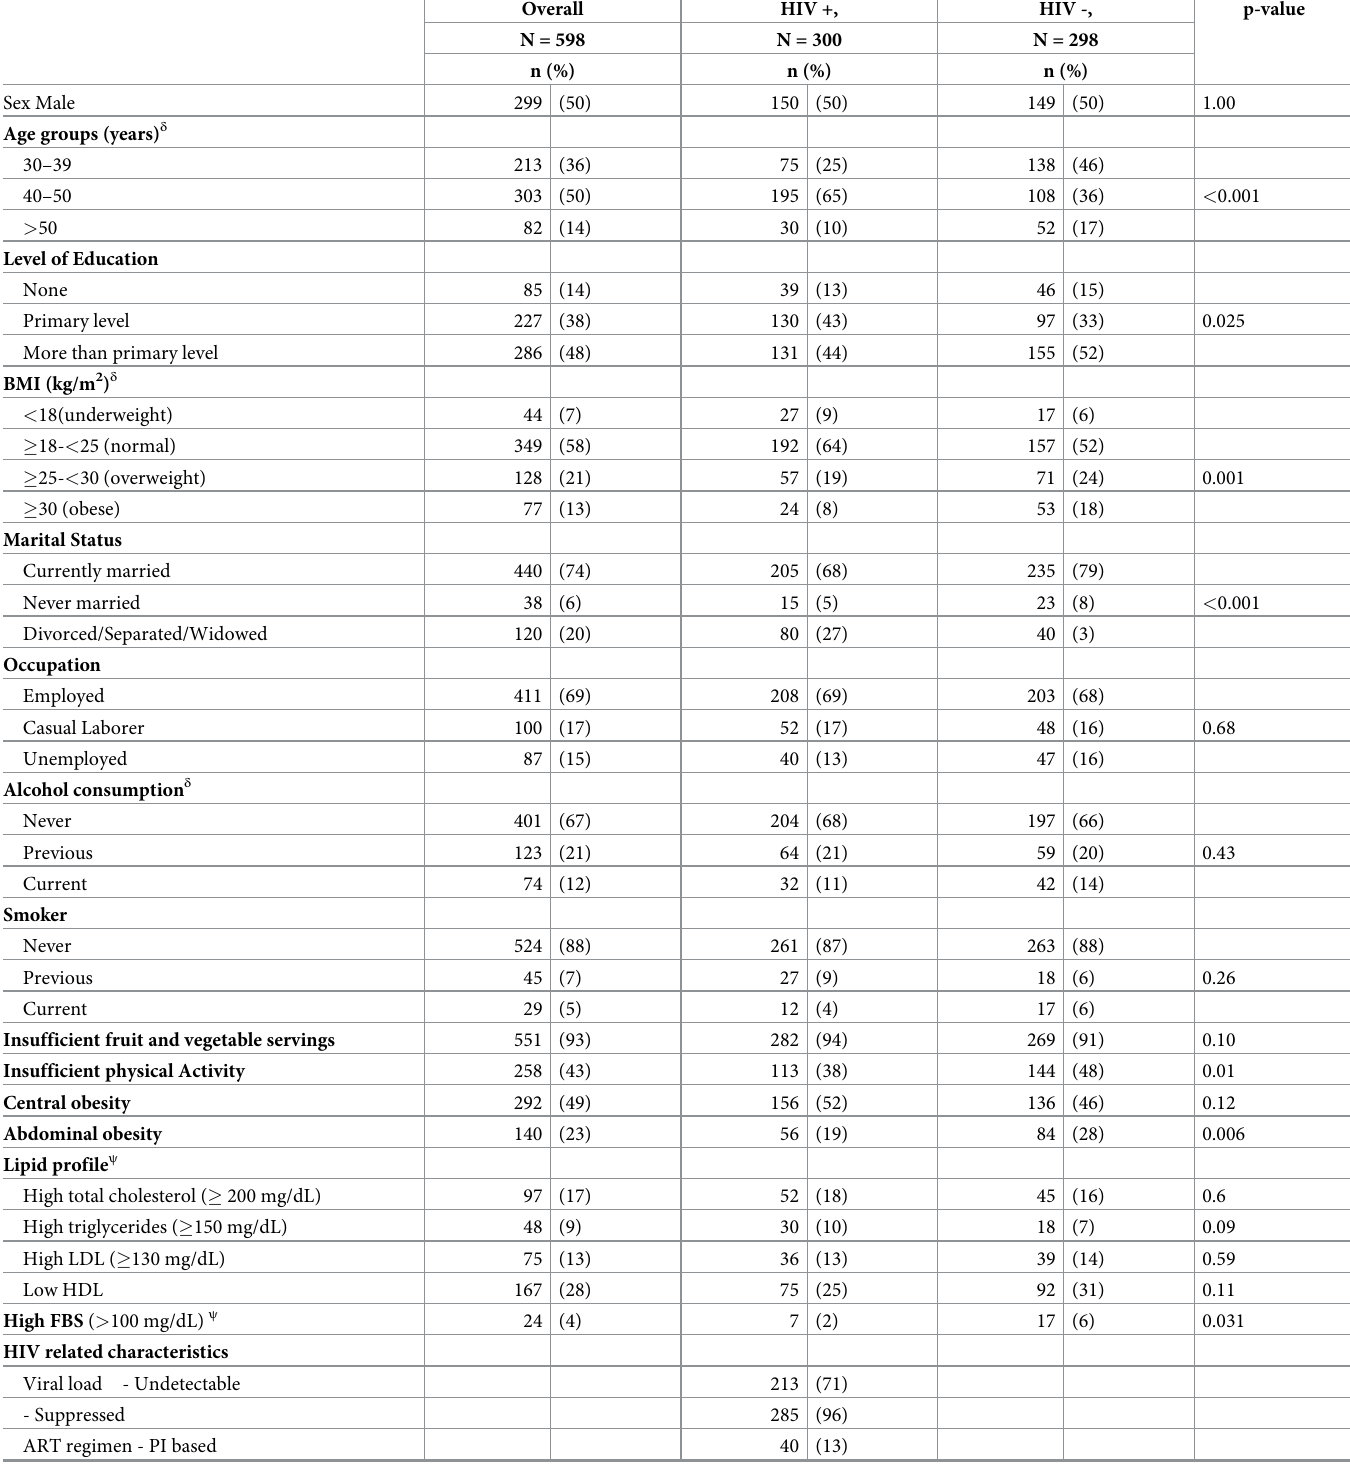
Table 1. Participant characteristics stratified by HIV status §